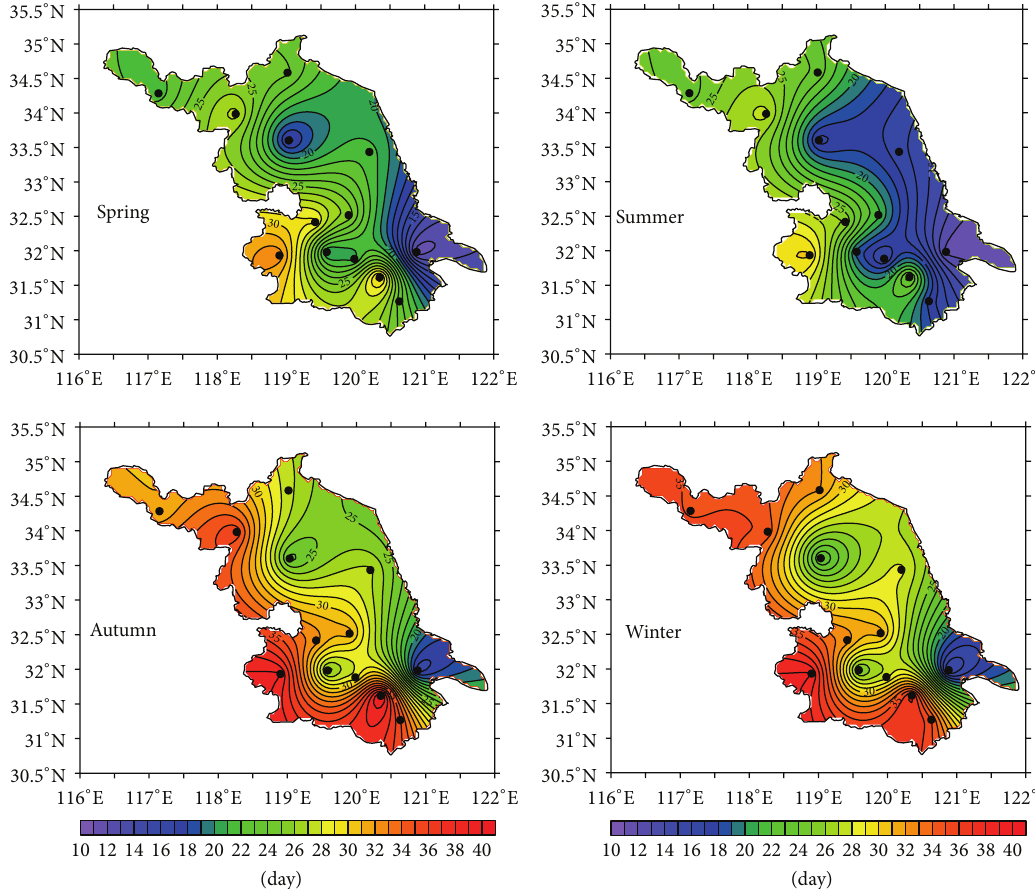
Figure 3: Spatial distribution of hazy day in four seasons during 1980 and 2012 (yearly average).